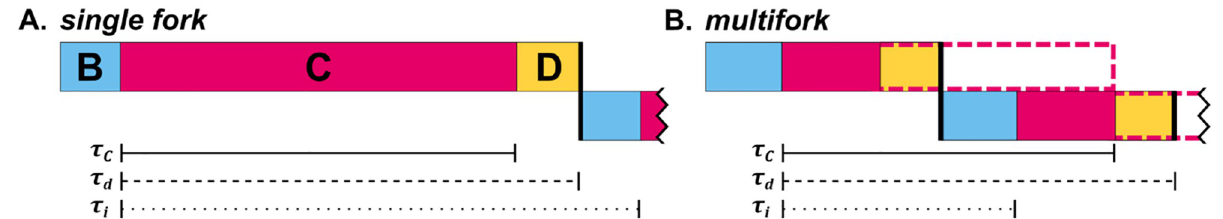
Fig 3. Stochastic timers. Visual representations of the timers τ i , τ C , and τ d in a cell undergoing single fork (A) and multifork (B) replication. These stochastic timers represent single-cell parameters. During multifork replication, C periods extend beyond a single division cycle. This overlap is indicated by extended dotted lines. Color schemes match Fig